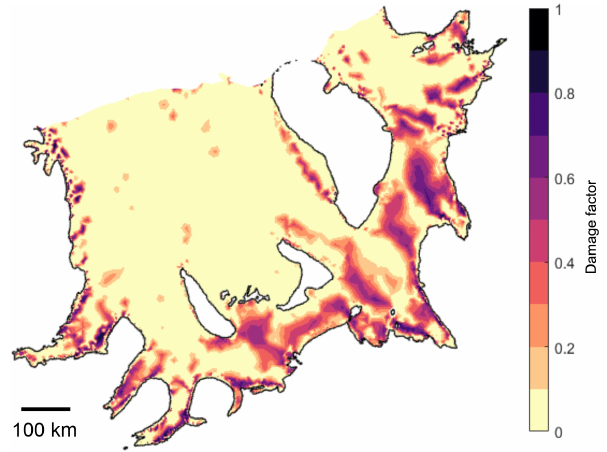
Figure C1. Damage factor field over the Filchner–Ronne Ice Shelf, as calculated with Eq.